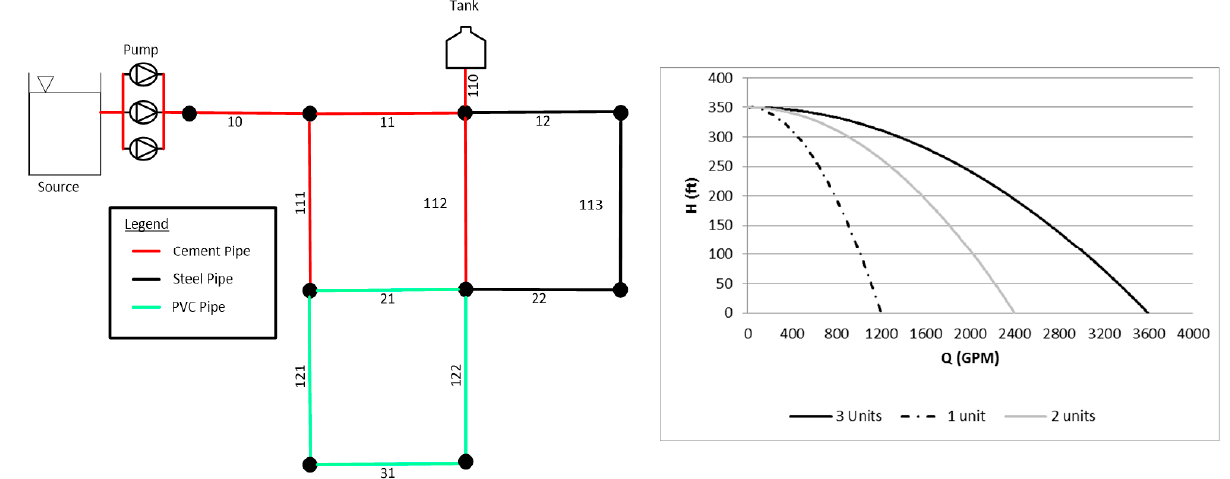
Figure 7. Net 1-c, with 3 pumping units and their curves.